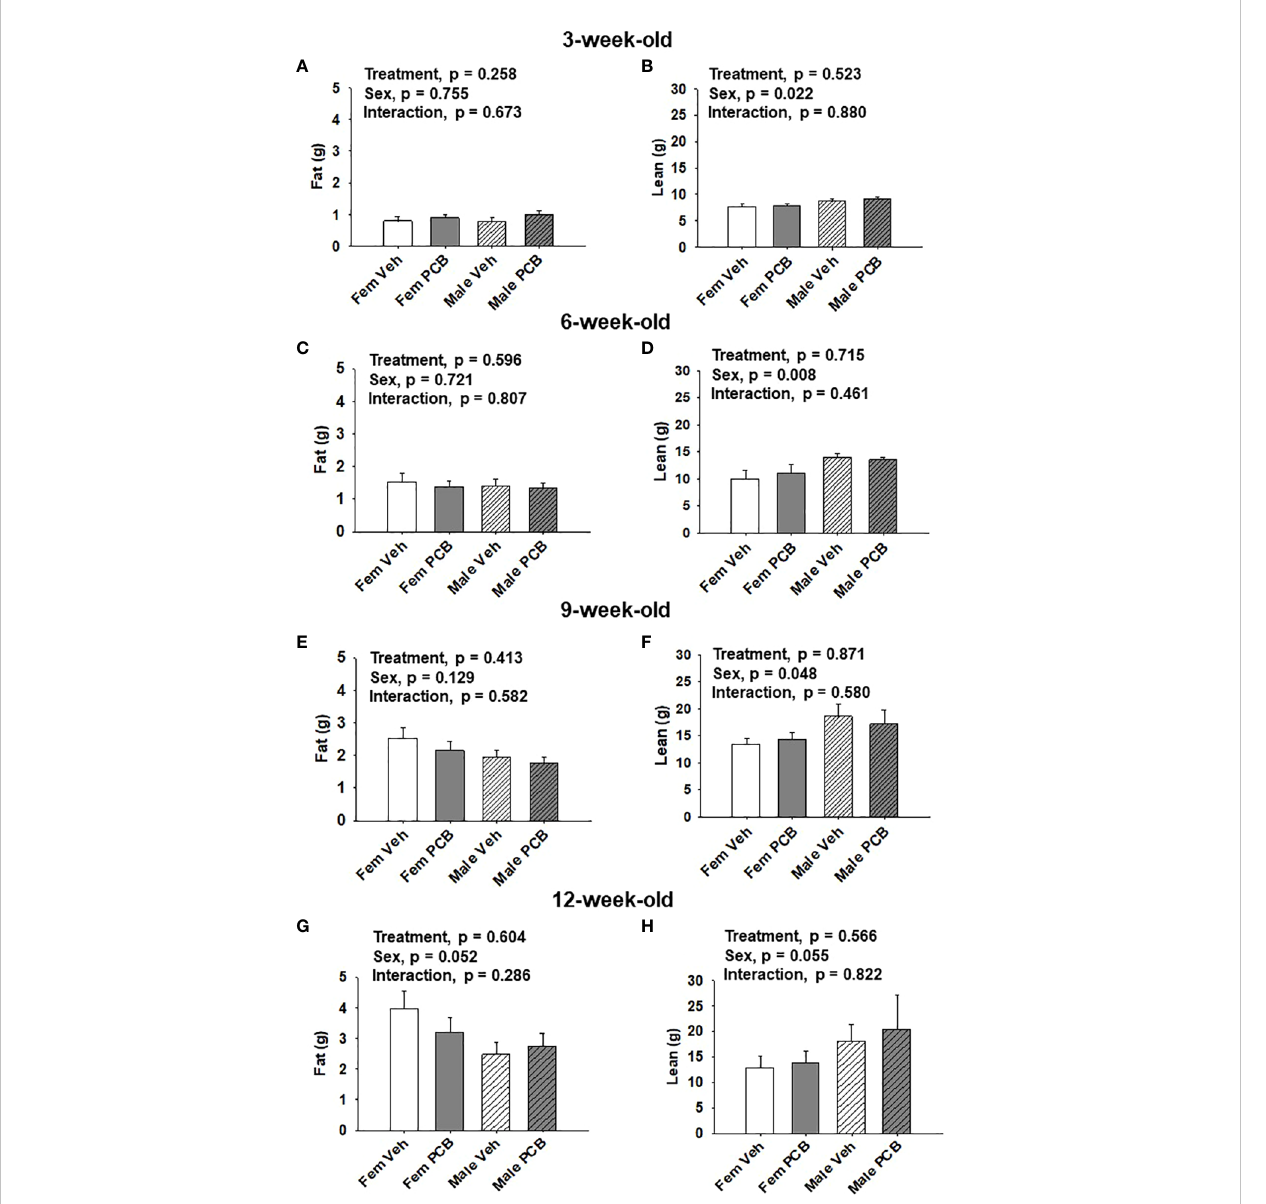
FIGURE 2 Maternal PCB126 exposure during the nursing period does not alter body composition. Body composition (lean and fat mass) of offspring was measured at 3, 6, 9, and 12 weeks of age via EchoMRI. Shown are the offspring data from 3 (A, B) , 6 (C, D) , 9 (E, F) and 12 (G, H) weeks of age. Fat mass and lean mass values are presented as the mean of litter means ± SEM (n = 9 per group). Data shown were analyzed using two-factor